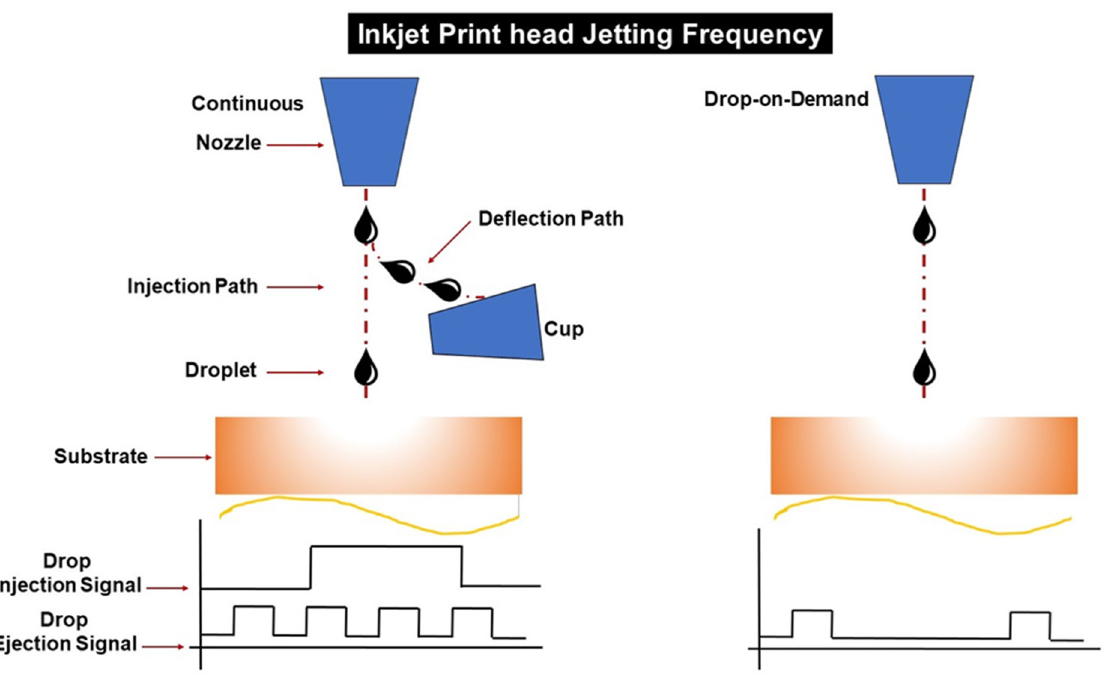
Figure 5. Schematic illustration of continuous and drop-on-demand ink-jet printing method .